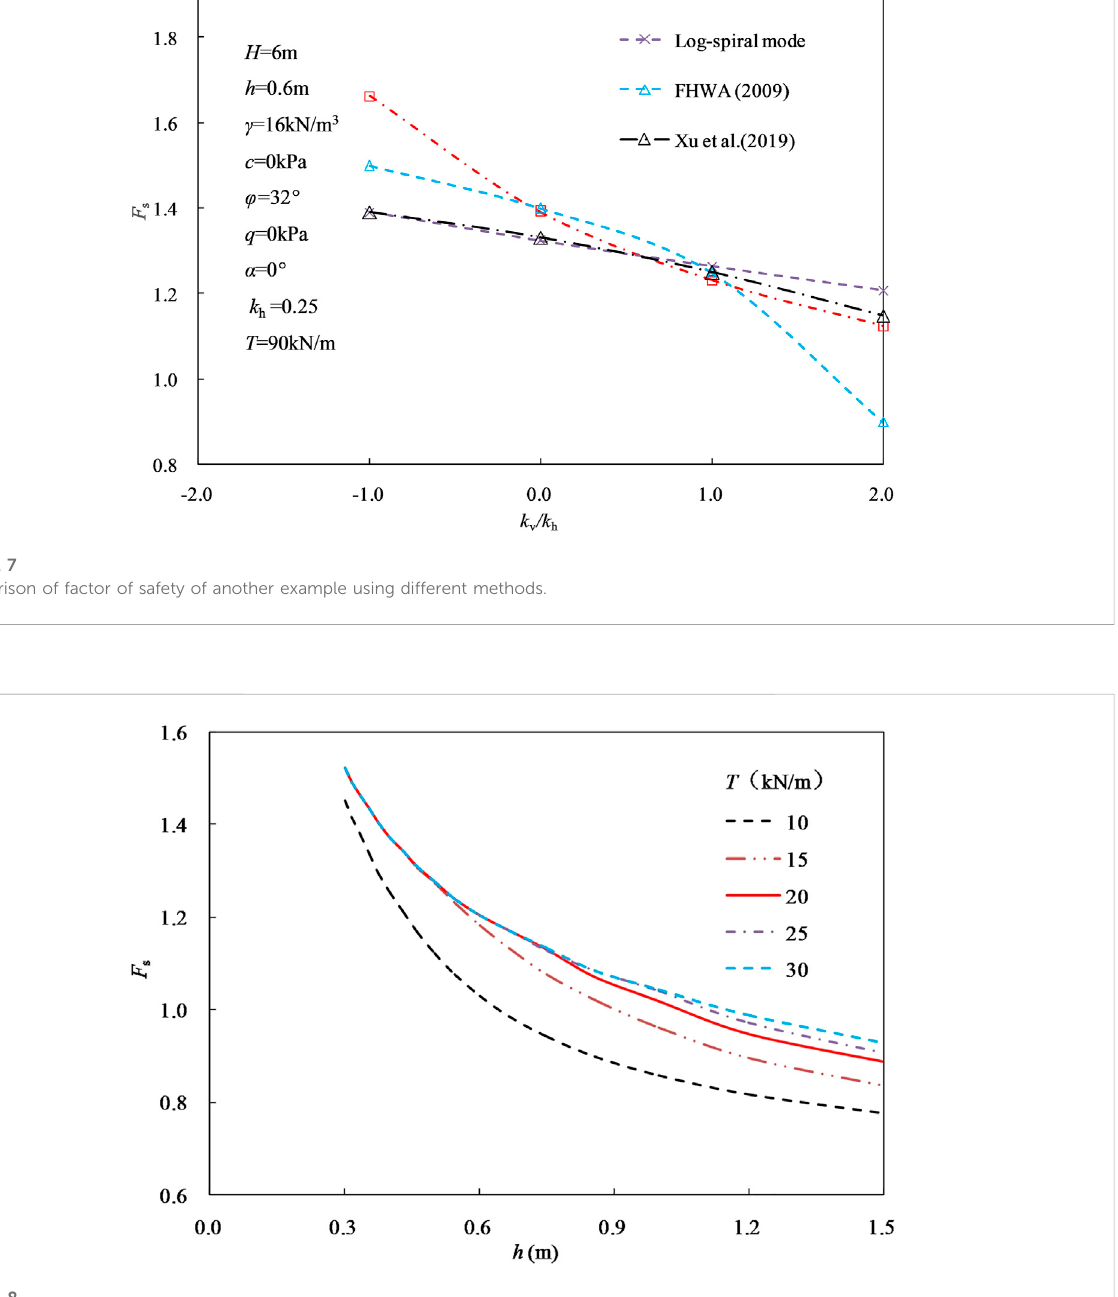
nonlinearly increasing with the reinforcement strength under F s = 1.0. However, the nonlinear characteristics are not obvious with the increase of F s . Additionally, the spacing is almost not